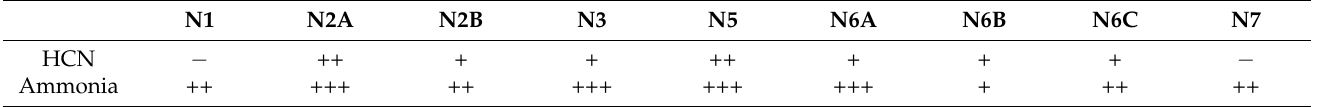
Table 4. HCN and NH 3 production by the isolated strains. The estimate was indicated as follows: no production ( − ); low production (+); medium production (++); high production (+++).